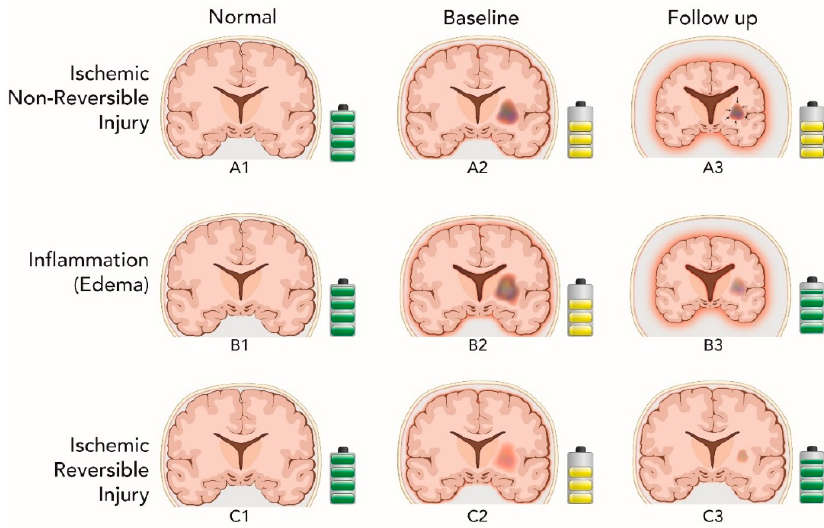
Figure 3. Conceptual descriptive figure showing the possible mechanisms that lead to white matter hyperintensity regression overtime and their associated effect on the brain volume and the cognitive performance (same conventions as in Figure 2). The upper row demonstrates the first potential mechanism of white matter hyperintensity (WMH) regression due to ischemic non-reversible injury. In A3, the WMH lesion contracts (black arrows) resulting in brain volume reduction compared to A2. Because the contraction is merely mechanical, memory performance is not changed compared to A2. The middle row illustrates inflammation as a potential cause of WMH regression. In B3, the edema resolves, the brain volume consequently decreases but memory is improved compared to B2. The difference between A3 and B3 is in expected memory performance. Lower row represents a third explanation of WMH regression, most consistent with our data. In C3, WMH lesion volume regresses, but brain volume and memory performance increase compared to C2. The difference between C3 and B3 is in brain atrophy, which is greater in B3.